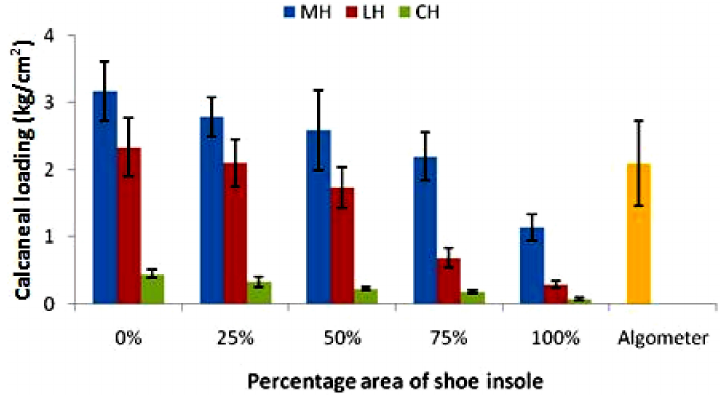
Figure 6. Calcaneal loading during standing for the five percentage areas of shoe insole, compared to the PMCP measured using the algometer (mean ± SD). Table 5. The distribution of pressure at the MH, LH and CH for each length of spur.